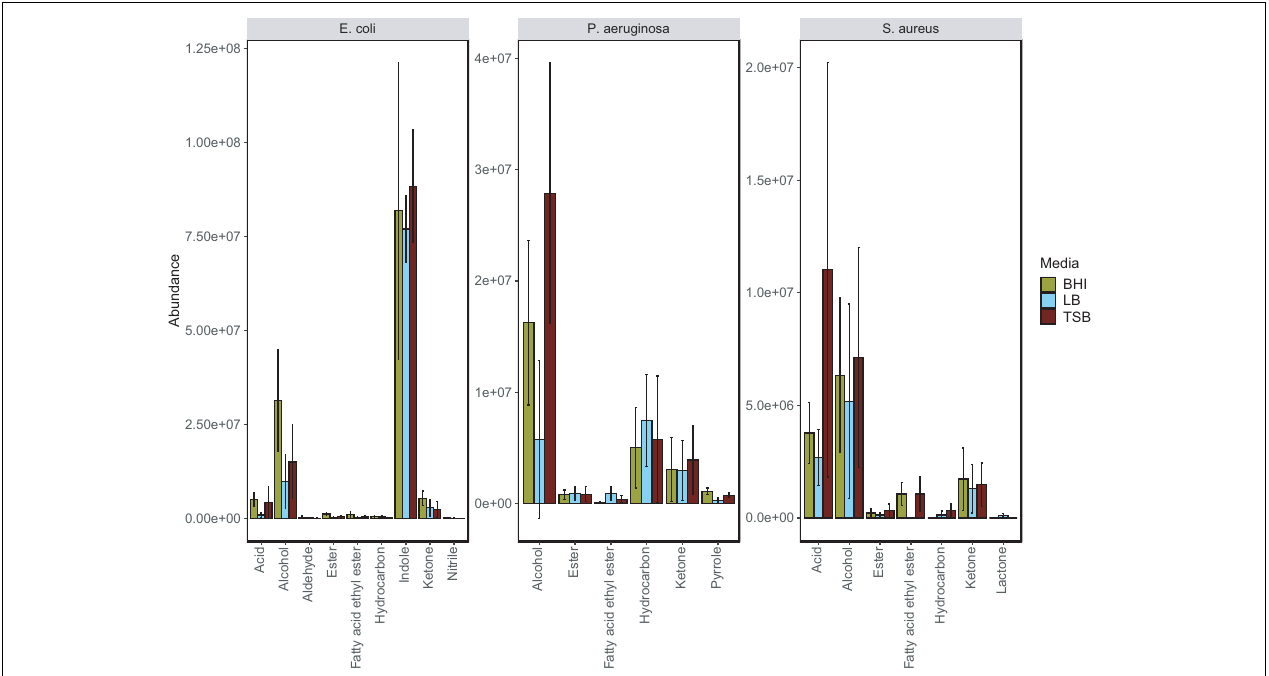
FIGURE 2 | Grouped bar plot illustrating the differences in emission of individual chemical classes in BHI, LB and TSB growth media by E. coli , P. aeruginosa and S. aureus . This bar plot was obtained by summing the mean abundance of each chemical class detected in each of the examined bacteria. Significant media-dependent differences are illustrated in the corresponding grouped boxplot ( Supplementary Figure 13